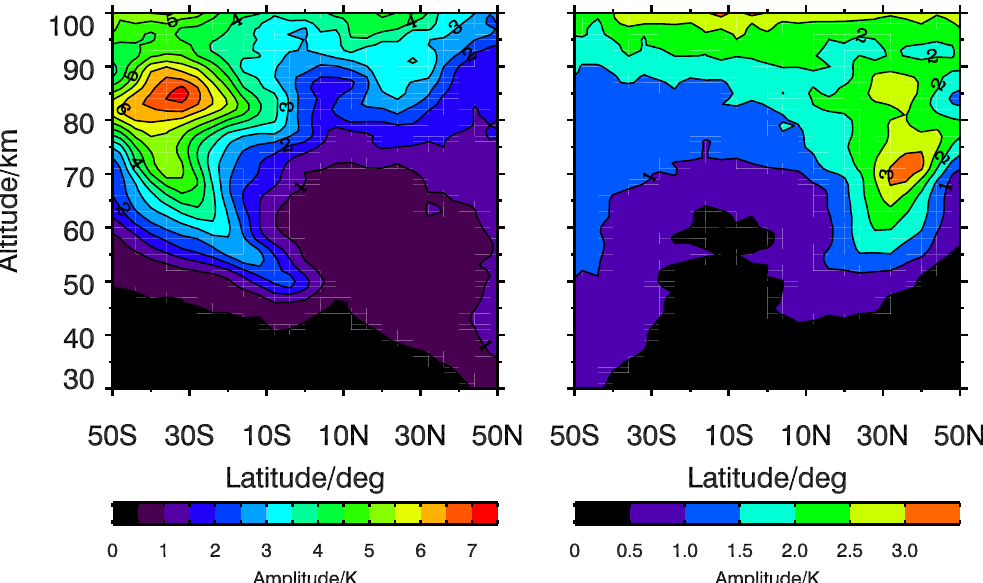
Fig. 2. Latitude–altitude distributions of averaged amplitudes of (2.13, W3) (left) and (2.04, W4) (right) for years